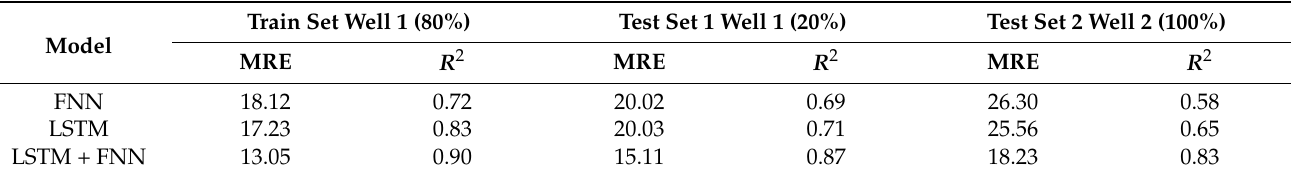
Table 4. Precision comparison of ROP prediction